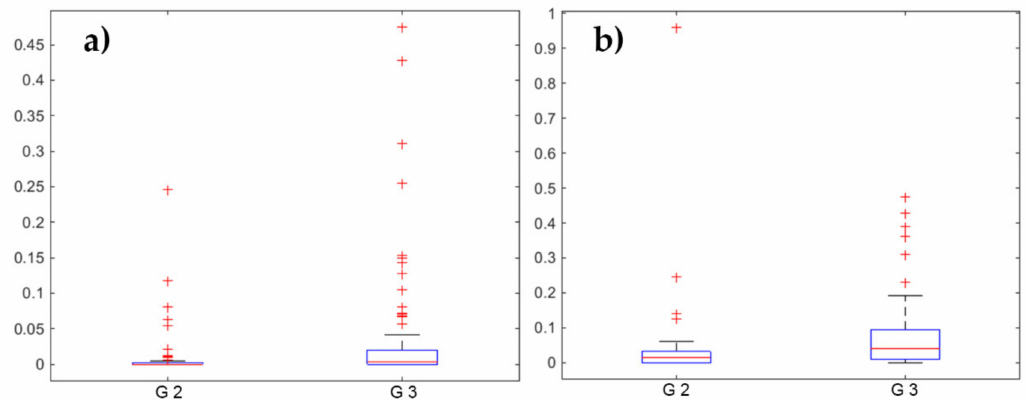
Figure 3. Box plots ( a , b ) comparing the numbers of ( a ) lymphocyte aggregates (LA) and ( b ) tertiary lymphoid structures (TLS) per mm 2 when separating the patients into two groups by using G2 versus G3 subgroup in CD3 + stained slides. Significant higher values of LA ( p = 0.0014) and TLS ( p = 0.0003) were found in the G3 subgroup. Please note the di ff erent scaling of the